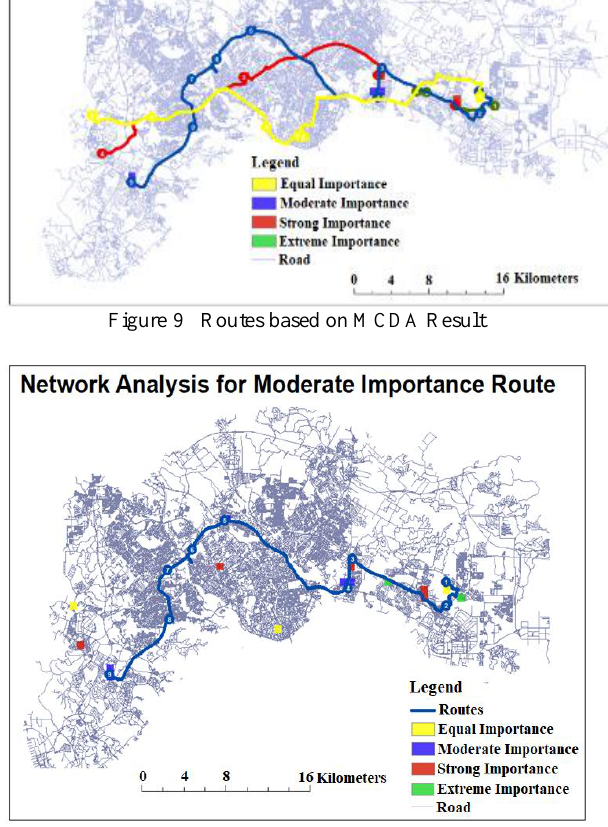
Figure 10 Moderate Importance Route map